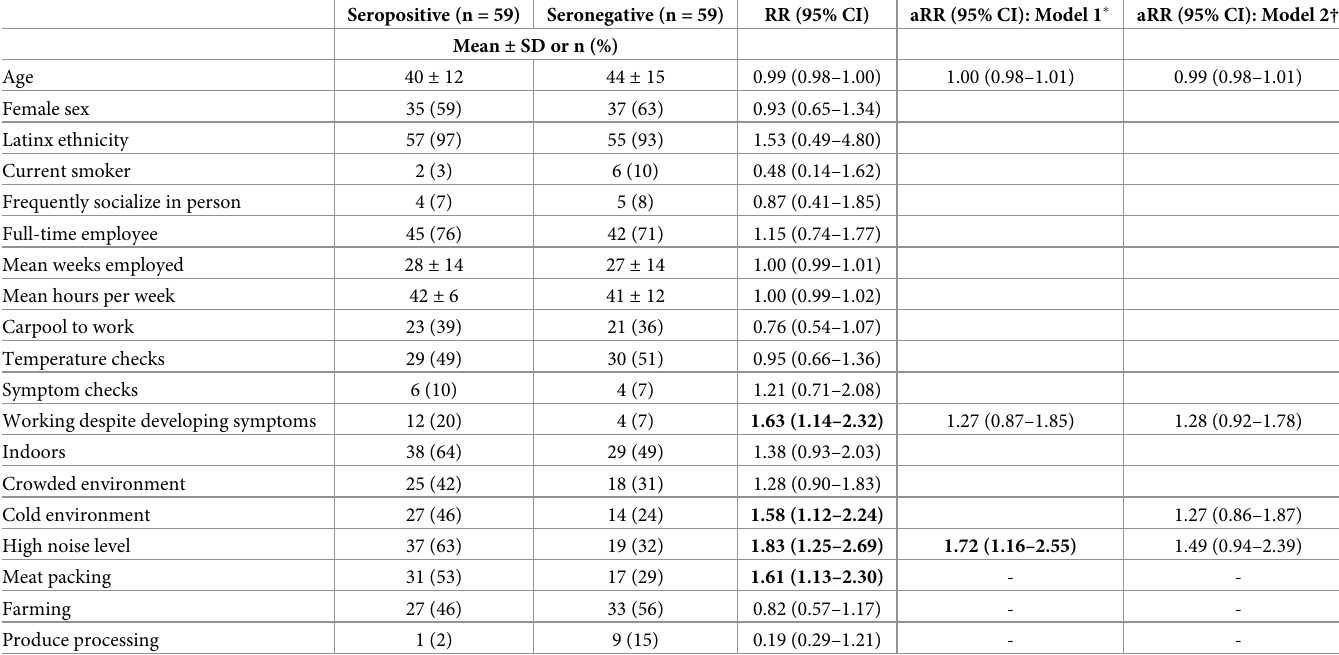
Table 2. North Carolina food processing worker and workplace characteristics associated with SARS-CoV-2 seropositivity (fall